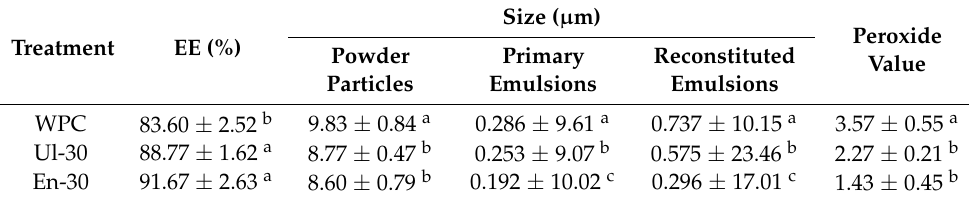
Size ( µ m) Peroxide ValuePowder Primary Reconstituted Particles Emulsions Emulsions